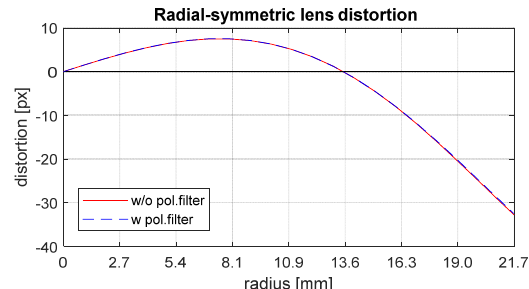
Figure 7. Radial-symmetric lens distortion curve of Nikon D4 with 35mm-ZEISS-lens with and without polarising